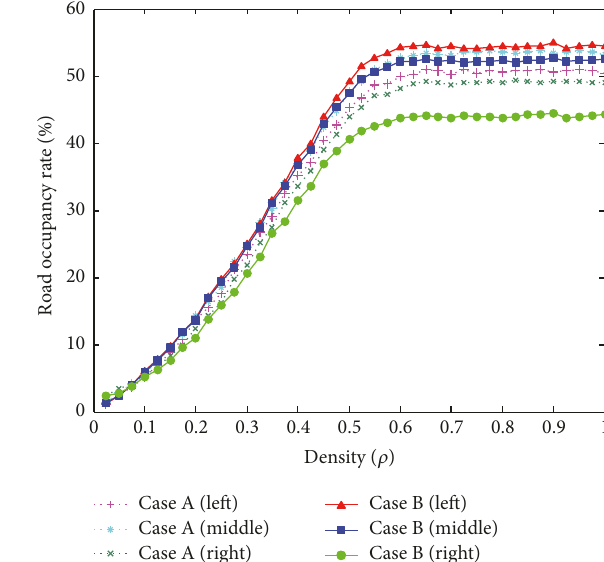
Figure 10: Lane-changing frequency of each lane with traffic density increasing in Case A and Case B.